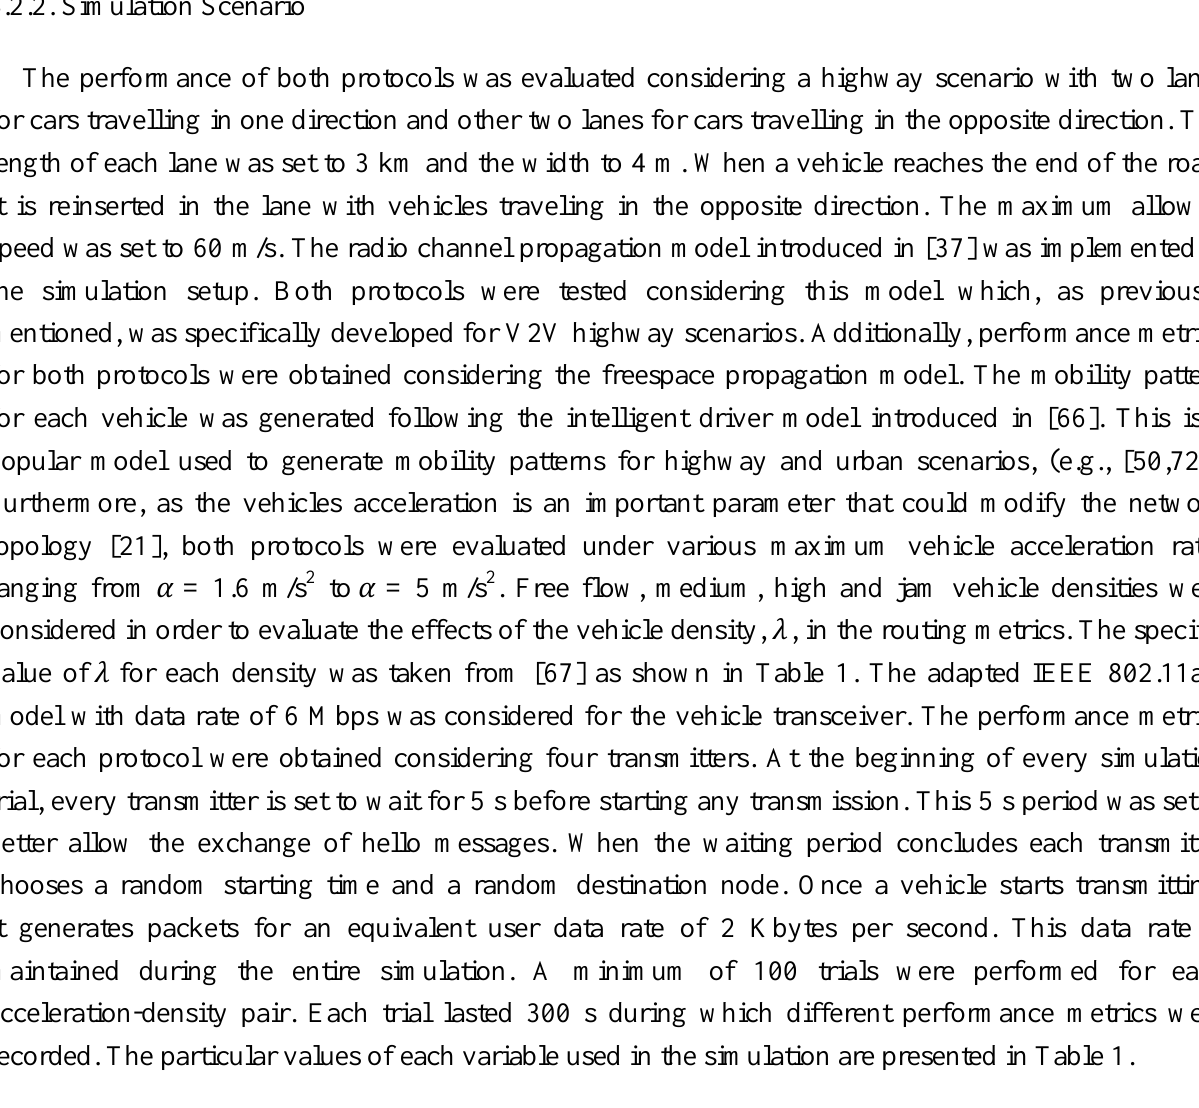
Table 1. Specific values used for each variable in the simulation